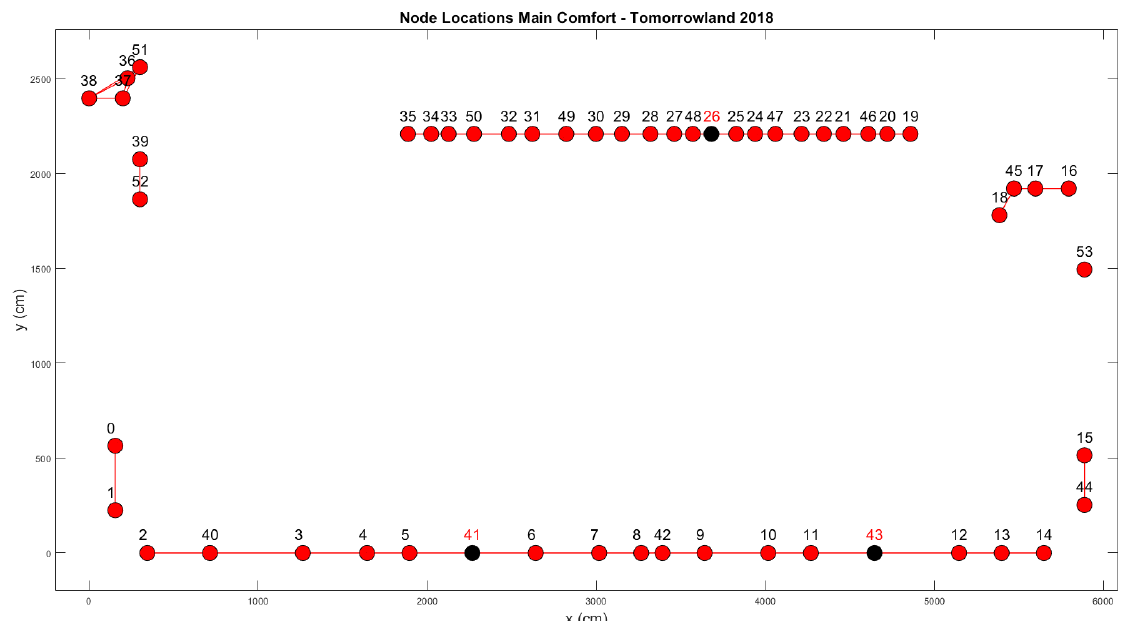
Figure 3. An overview of the discarded links within the Main Comfort